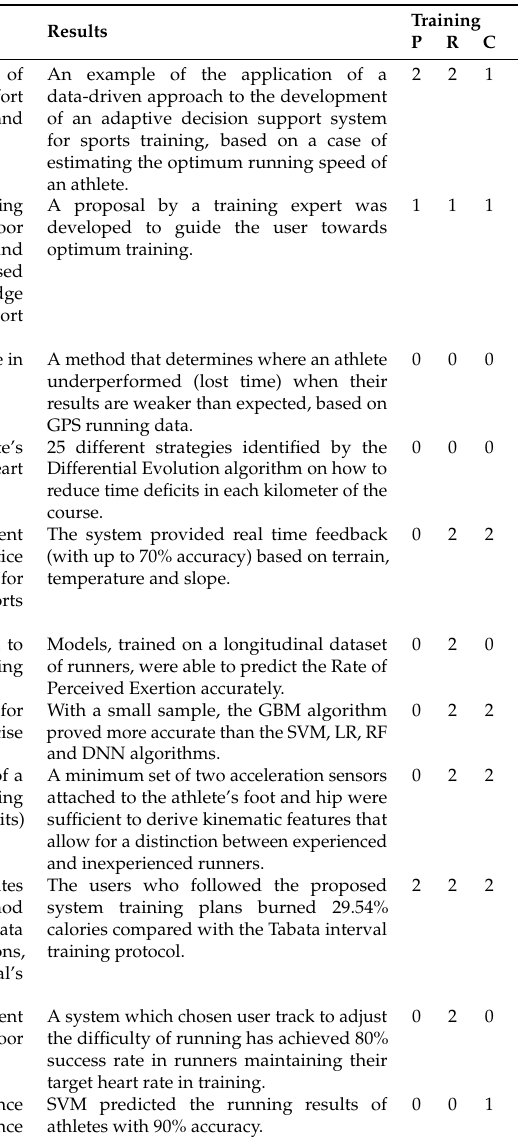
Table 9. Identified studies in the domain of